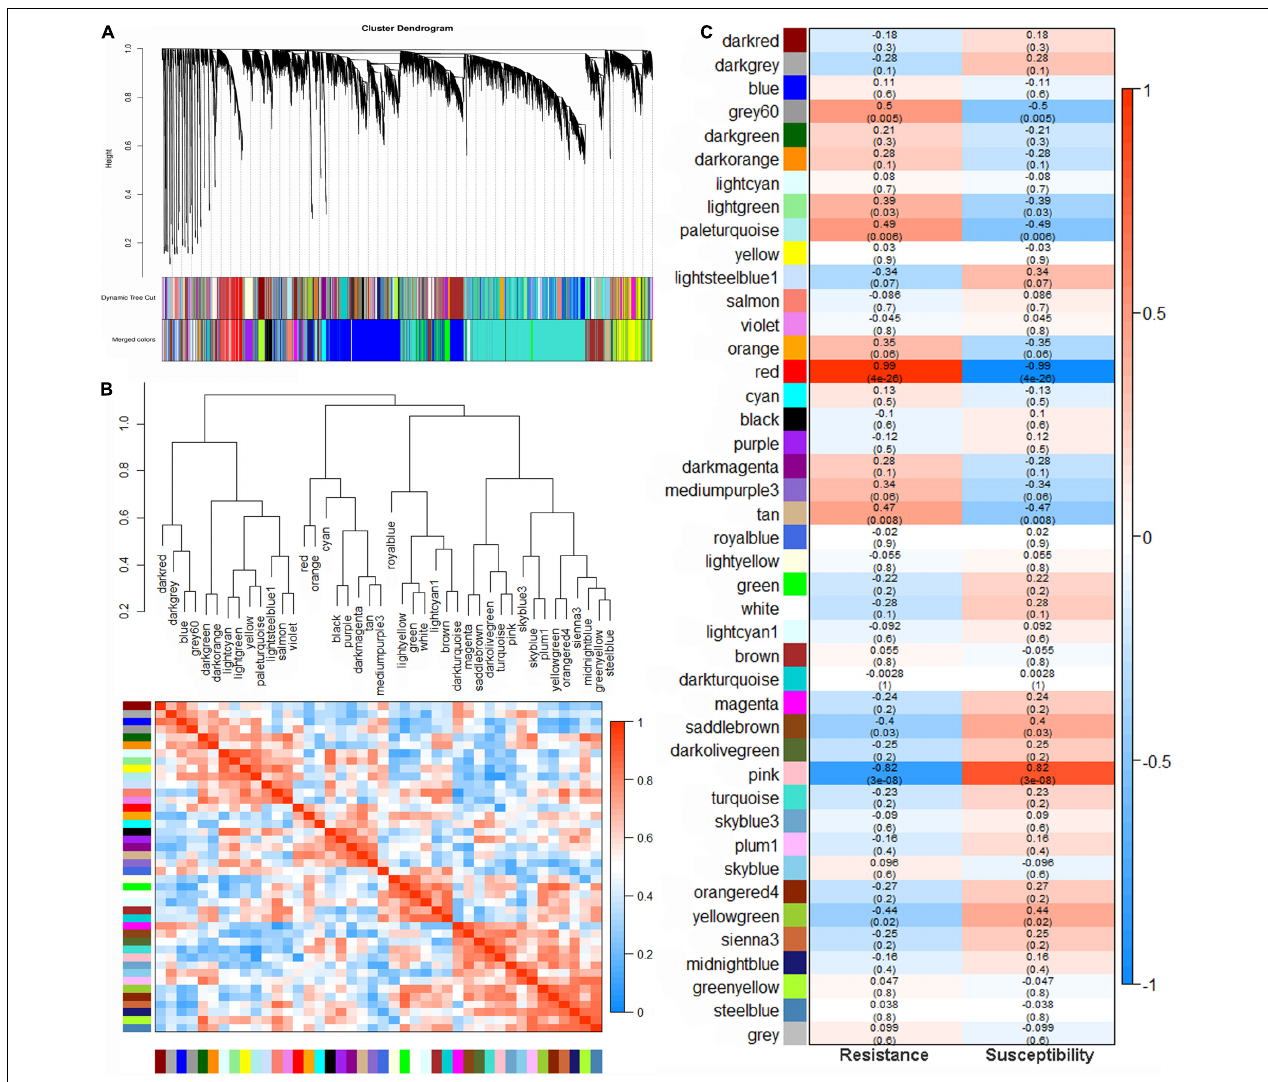
FIGURE 3 | Weighted gene co-expression network analysis (WGCNA) in mung bean infected with Fusarium wilt. (A) Hierarchical cluster diagram of co-expression modules according to WGCNA. (B) Gene co-expression modules showing the cluster dendrogram (above) and the heatmap for the correlation coefficient between the modules (below). (C) Module–trait relationships. Each cell contains the corresponding correlation and p